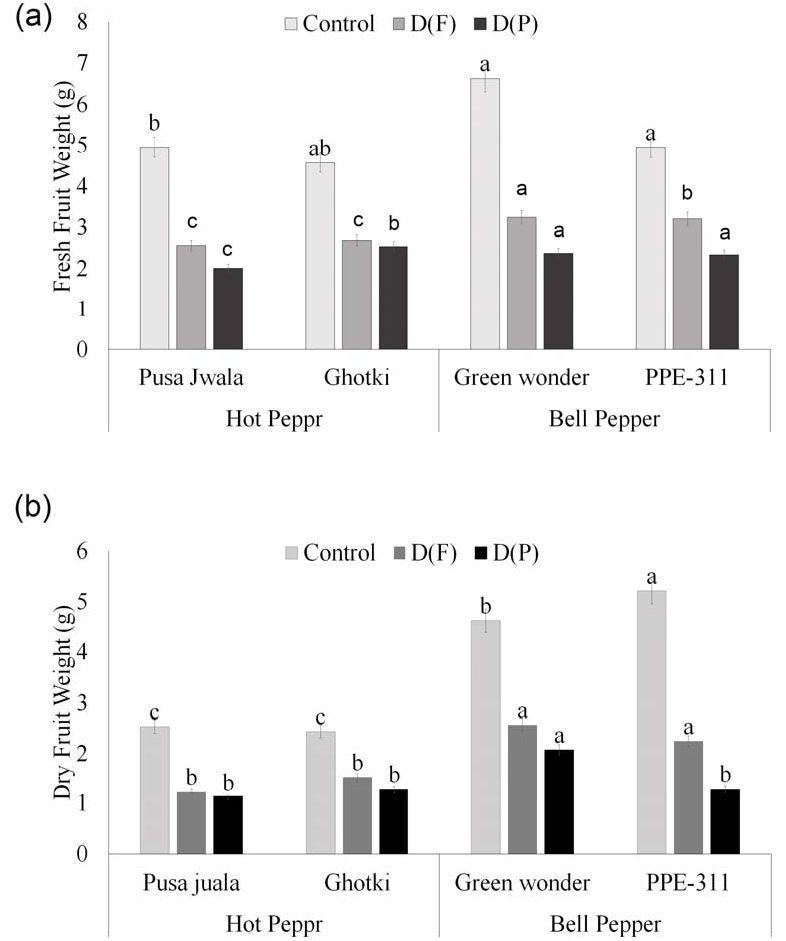
Figure 5. Fresh ( a ) and dry ( b ) fruit weight. Means of three repetitions for each genotype with the same letters indicate the same means, and different letters indicate significant differences. Vertical bars represent the standard error of means (bars = ±se). DF = water stress at flowering stage, DP = water stress at the pod formation stage.